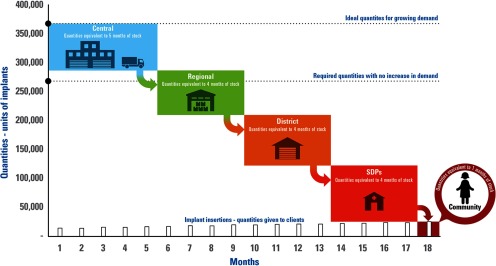
Pictorial Depiction of Maximum Inventory Needs (System and Level) and Flow Through In-Country Supply Chain With Growing Demand in a Sample Country